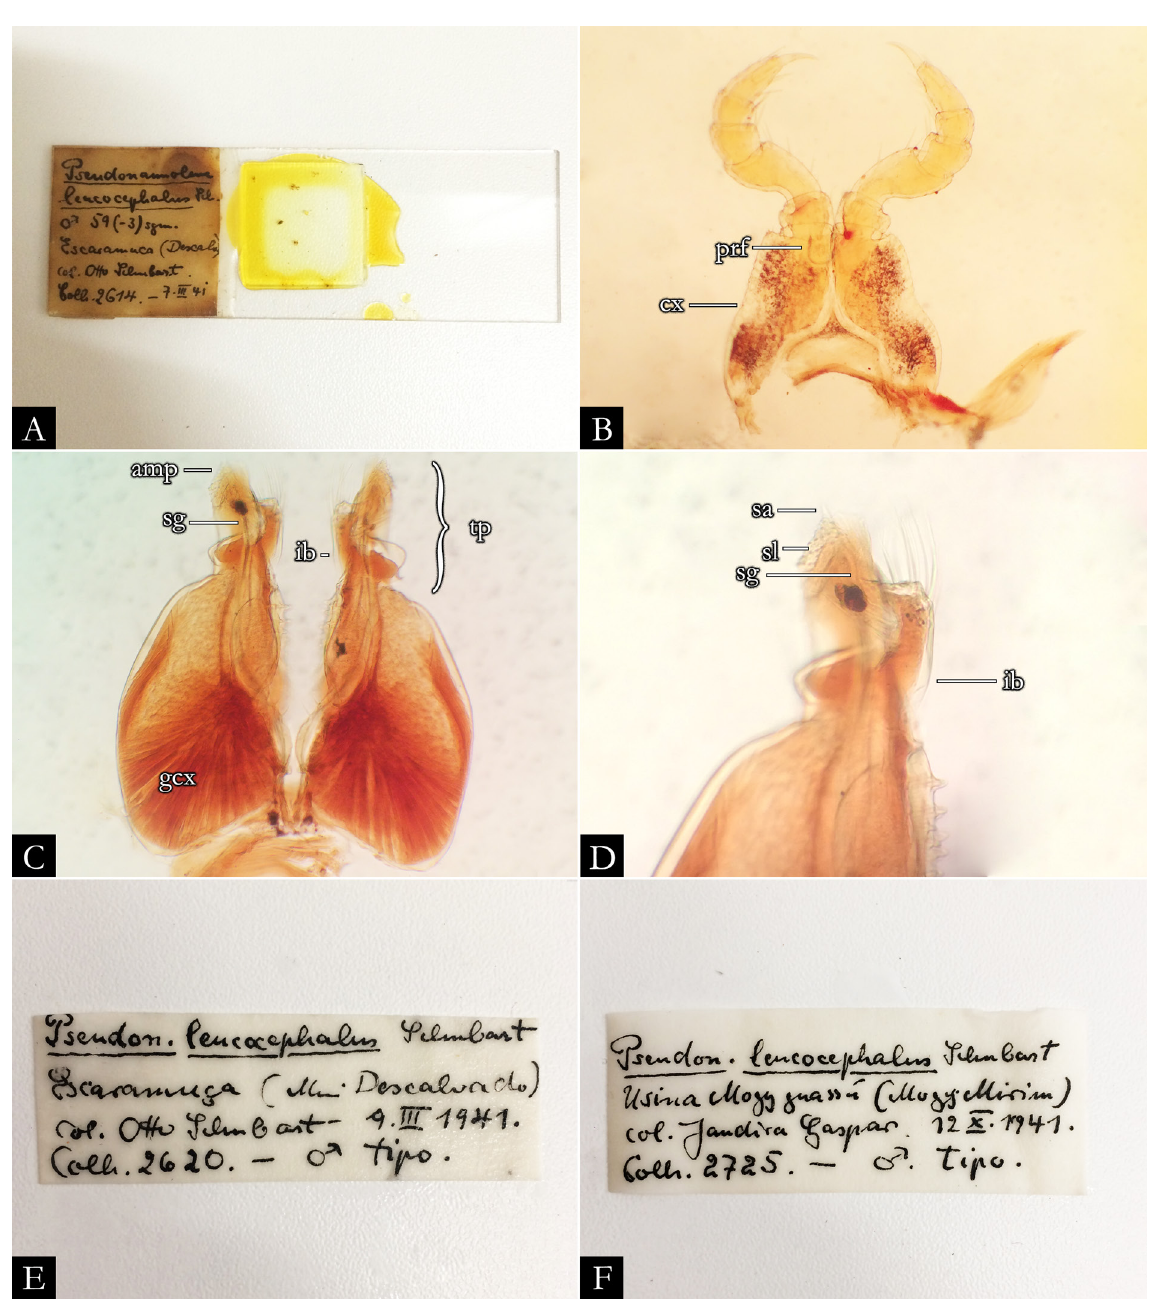
Fig. 80. Pseudonannolene leucocephalus Schubart, 1944, ♂ (MZSP). A . Sexual structures and gnathochilarium of type material mounted on microscope slide. B . First leg-pair. C . Gonopods, in oral view. D . Detail of telopodites, in oral view. E–F . Original labels of type material. Abbreviations: see Material and methods. Images not to